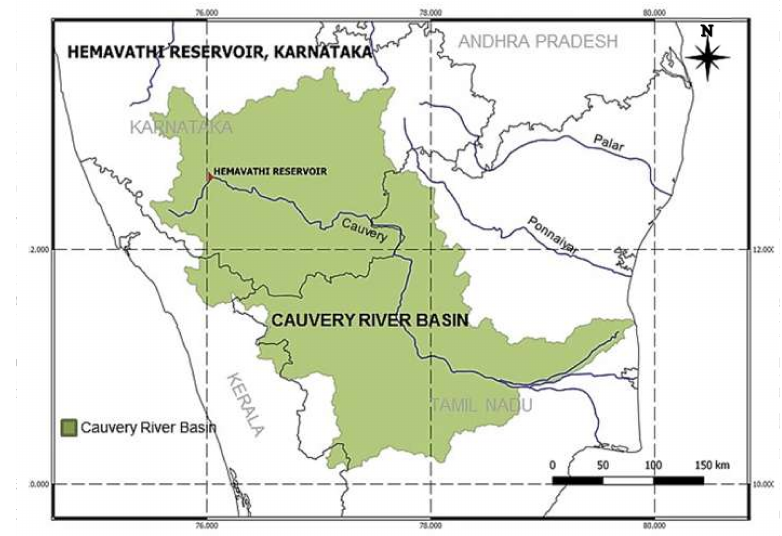
Figure 4. Location of Hemavathi Reservoir – Upper Cauvery Basin. Blue line indicates the river